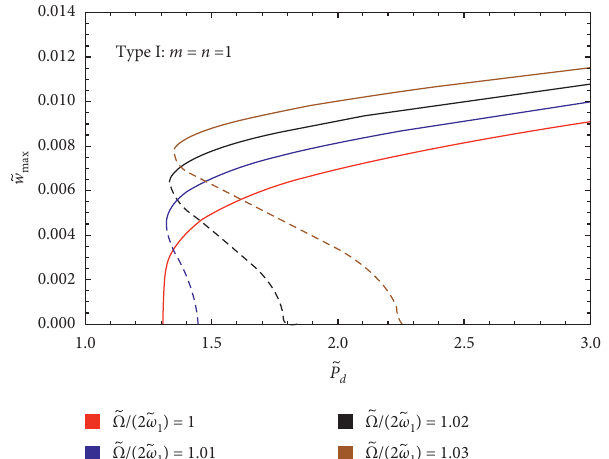
Figure 10: Influence of excitation frequency on force-response curves of BDFG beam with m � n � 1, L / h � 20, 􏽥 c